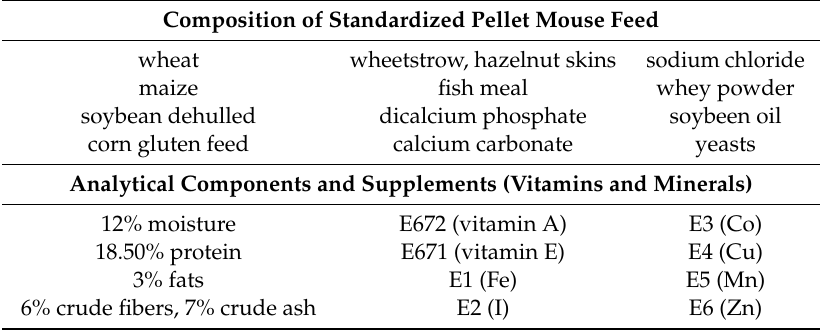
Table 1. Composition of standardized pellet mouse